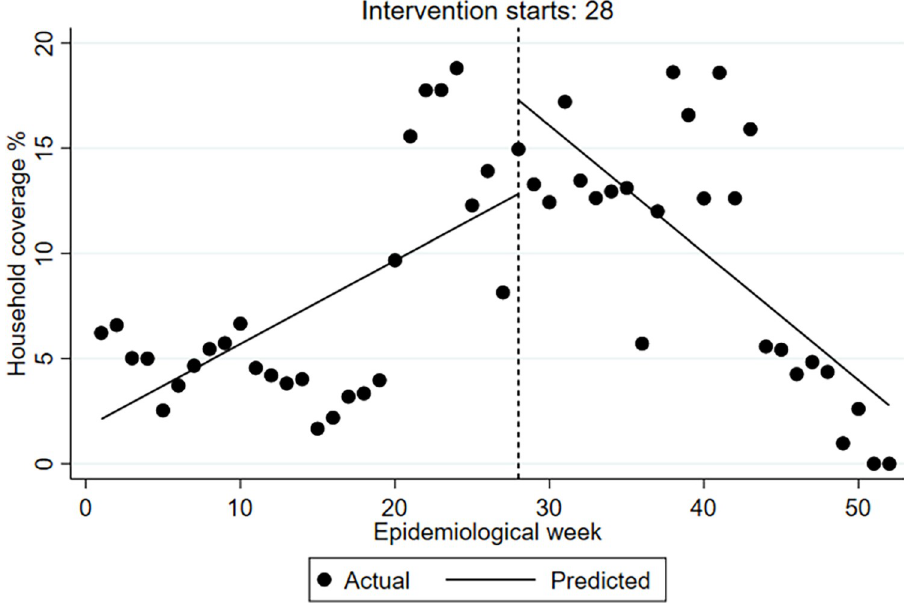
Fig 4. Segmented time-series of household coverage % with larval control at baseline (pre-alarm signal period), at the week (28) of alarm signal and post-alarm signal period. One example of non-outbreak districts is presented.